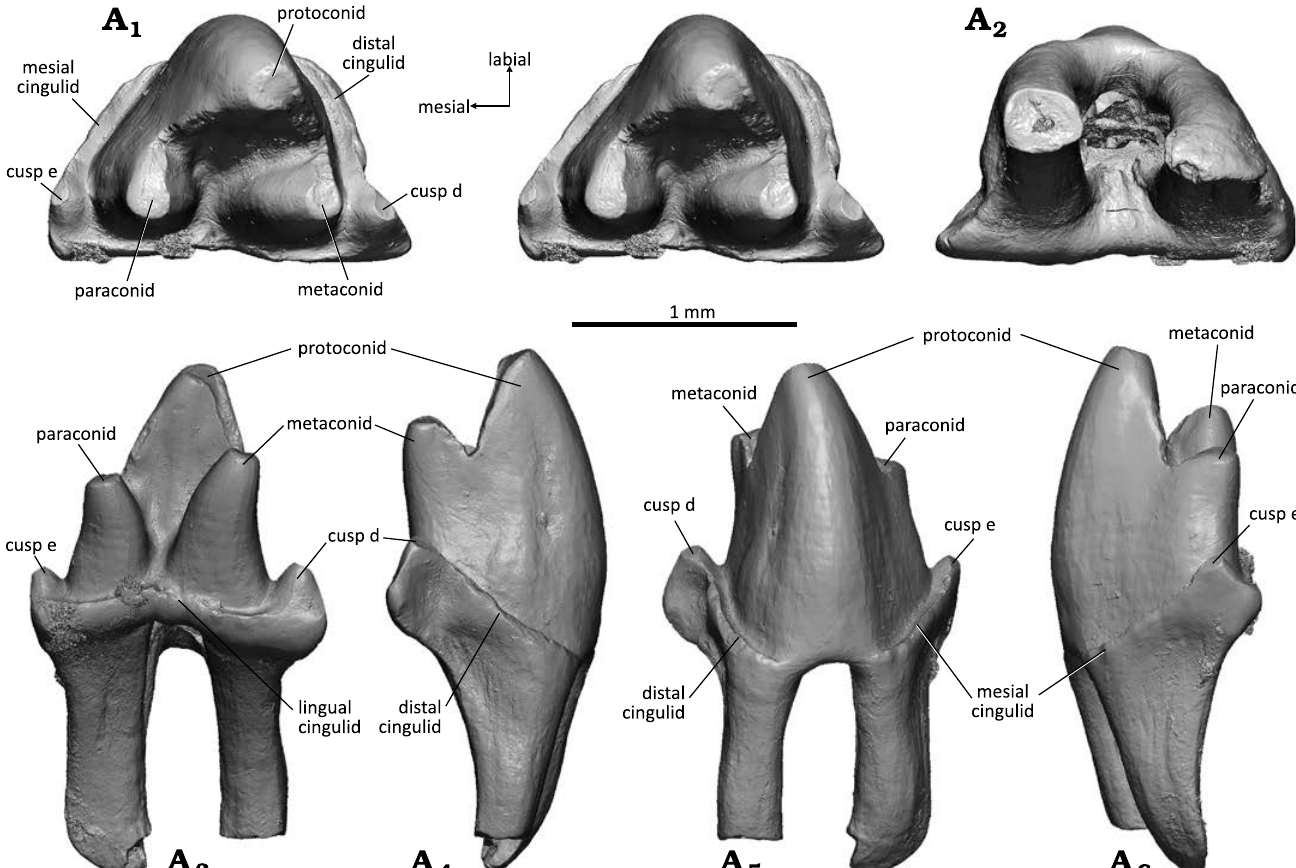
Fig. 5. Spalacotheriid mammal Cifellitherium suderlandicum gen. et sp. nov., WMNM P82305 (holotype) from Busche Quarry near Balve, North Rhine- Westphalia, Germany, Barremian–Aptian (Lower Cretaceous). Right lower molar in occlusal (stereopair, A 1 ), ventral (A 2 ), lingual (A 3 ), distal (A 4 ), labial (A 5 ), and mesial (A 6 )